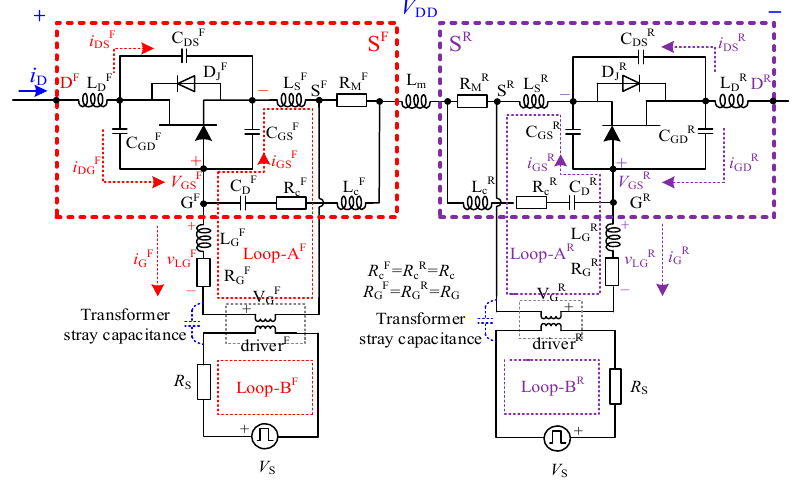
Figure 3. Transient of the SiC JFET-based BDSs.